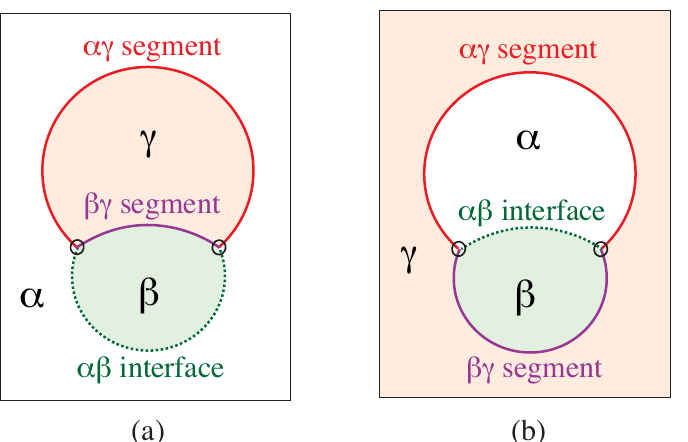
Figure 1. Geometry of vesicle-droplet systems which involve three liquid phases α (white), β (green), and γ (pink). The phases α and β represent two coexisting phases that arise via segregative or associative liquid–liquid phase separation: ( a ) Phase separation in the exterior solution and adhesion of the condensate droplet β to the outer leaflet of the vesicle membrane; and ( b ) Phase separation in the interior solution and adhesion of the β droplet to the interior leaflet of the membrane. The γ phase corresponds to an inert spectator phase. The αβ interface (dashed green line) and the vesicle membrane form the contact line (open circles) which partitions the vesicle membrane into two segments, the αγ segment exposed to the α and γ phases as well as the βγ segment in contact with the β and γ